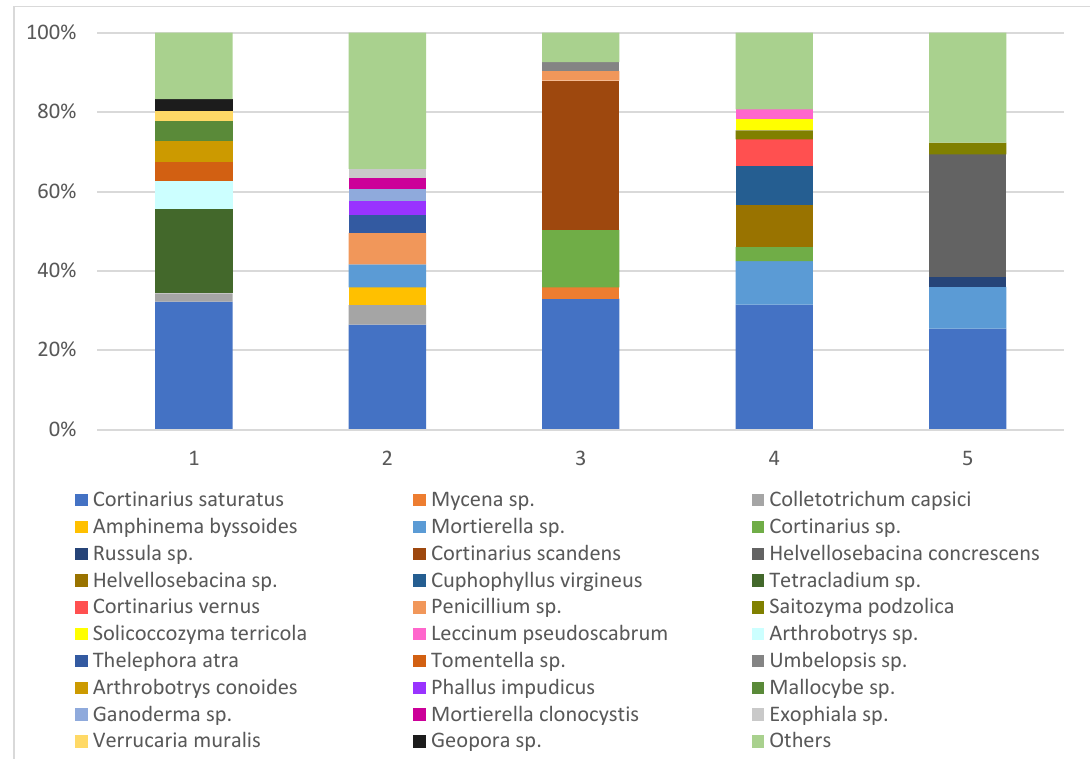
Figure 3. Fungal communities detected in the surrounding soil of orchids. (1) E. atrorubens (Dobšin á ); (2) E. atrorubens (Jasenie); (3) P. bifolia (Jasenie); (4) E. pontica (Sirk); (5) C. longifolia